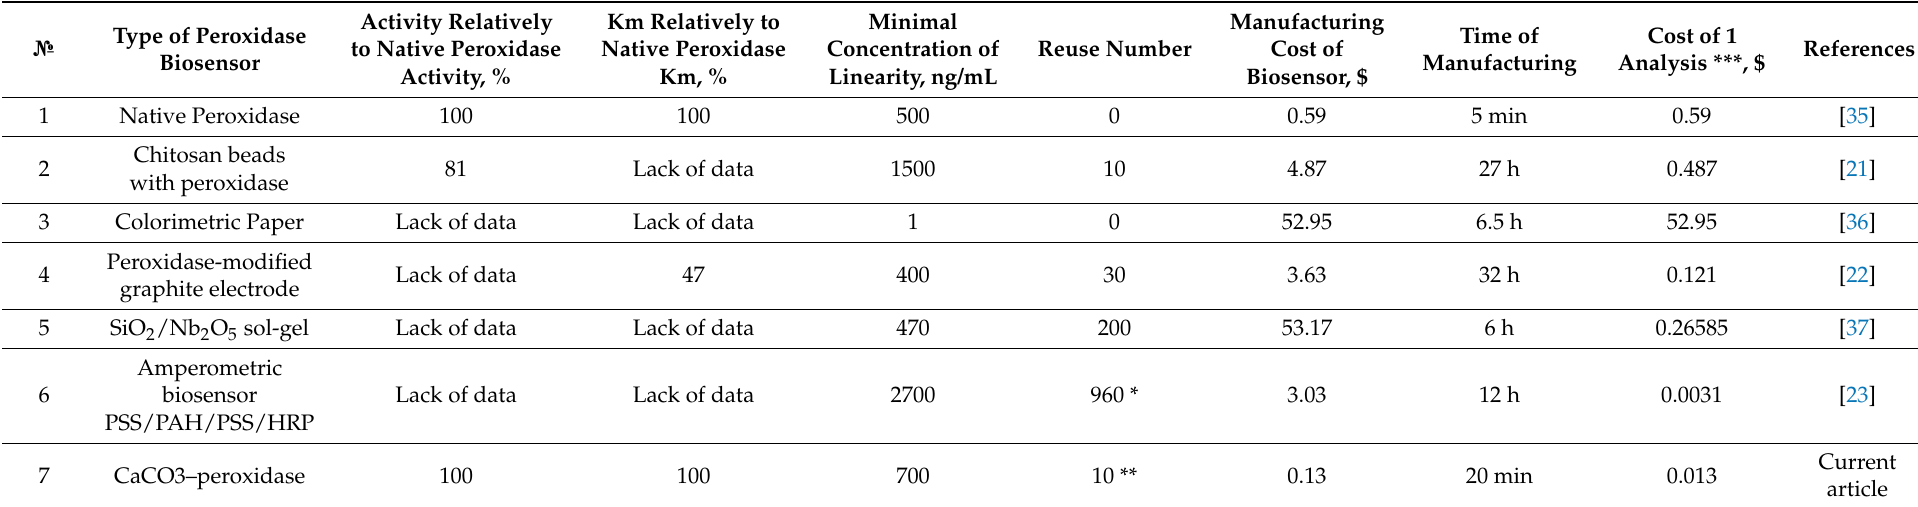
Table 1. Compared characteristics of detection systems based on immobilized